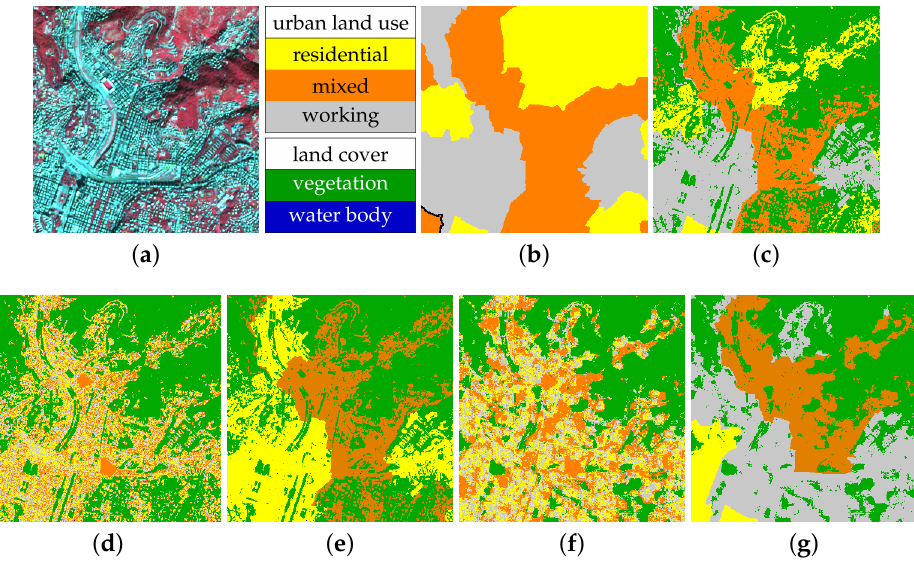
Figure 12. Details of ( a ) the Sentinel-2 false colour composite, ( b ) the ground truth for the urban land uses of the OD zones, and the maps obtained by ( c ) the proposed pixelwise decision fusion method; ( d ) the classification of only the spectral channels; ( e ) the soft-majority voting applied to the pixelwise posteriors estimated from only the spectral channels; ( f ) the classification in the stacked feature space of spectral channels, NDVI, and texture features; and ( g ) the soft-majority voting applied to the pixelwise posteriors estimated in the stacked feature space. Size of the crop area: 300 ˆ 300 pixels, 3 km ˆ 3